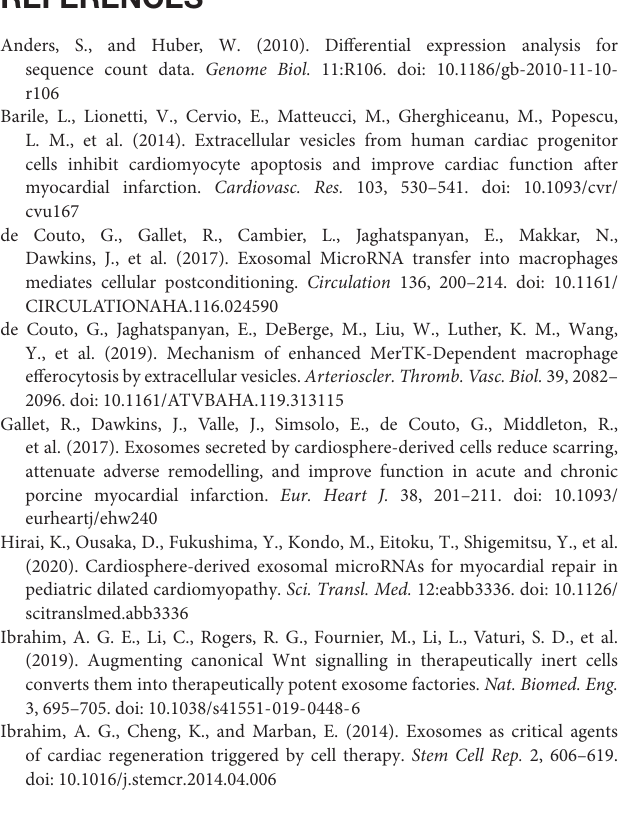
Supplementary Figure 1 | Augmented expression of TDO2 has a global effect on the gene expression profile of neonatal human fibroblasts. (A) Sequencing of cardiosphere-derived cells (CDCs) treated with BIO revealed TDO2 to be the gene most upregulated. (B) TDO2 expression 2 passages after lentiviral transduction and selection by puromycin. (C) Secreted kynurenine levels from nHDF versus nHDF TDO2 cell cultures as tested by ELISA ( n = 5). (D) Visualization of mRNA sequencing data showing global gene expression in nHDFs before and after transduction. Including significantly ( p ≤ 0.001) differentially expressed genes (direction delineated by colored arrows). (E) Heat map visualizing differentially expressed genes ( p < 0.001) post TDO2 augmentation. (F) Volcano plot